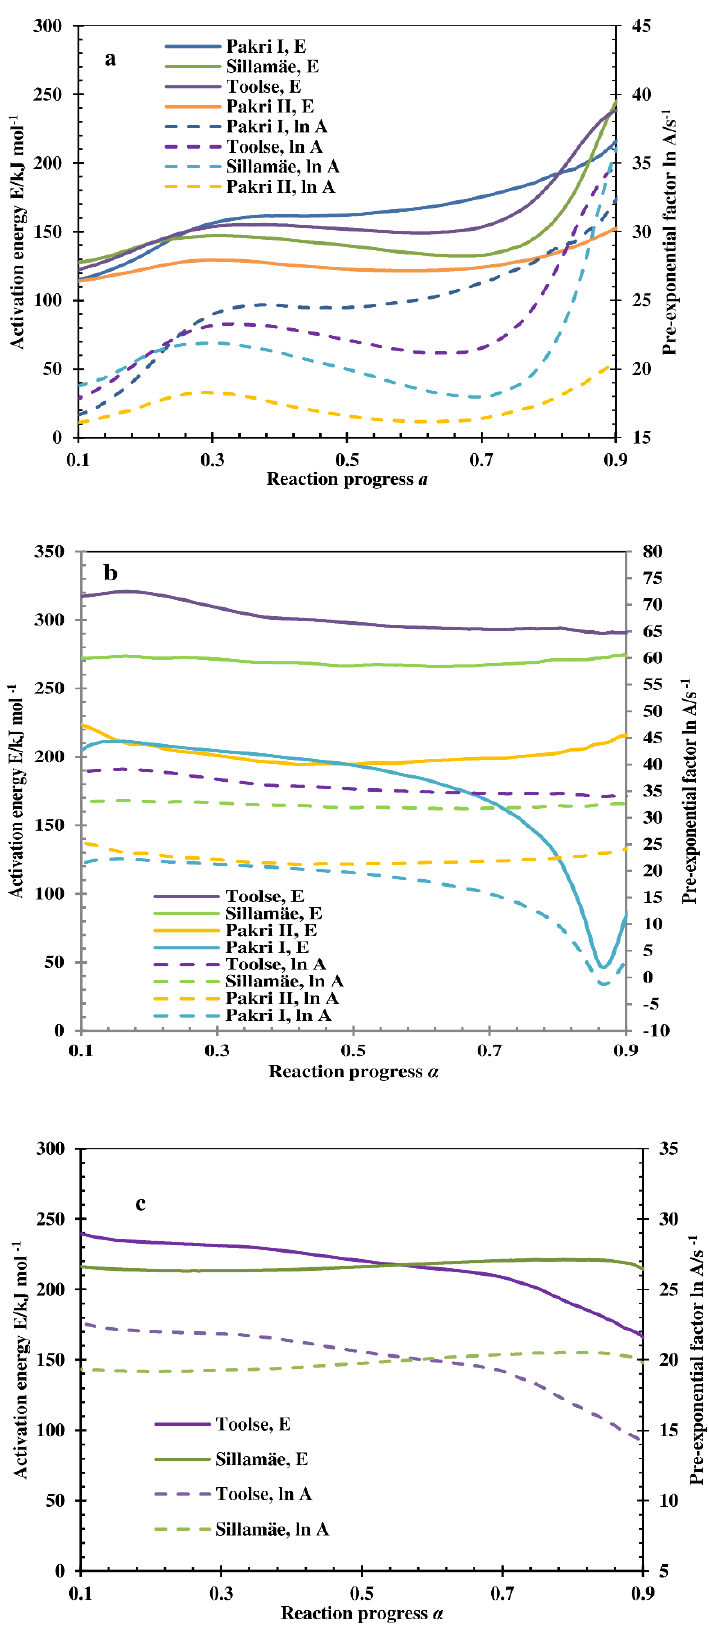
Figure 10. Activation energy E and pre-exponential factor ln A values determined by Friedman analysis as a function of conversion level α for GA samples: step I ( a ), step II ( b ), and step III ( c ).